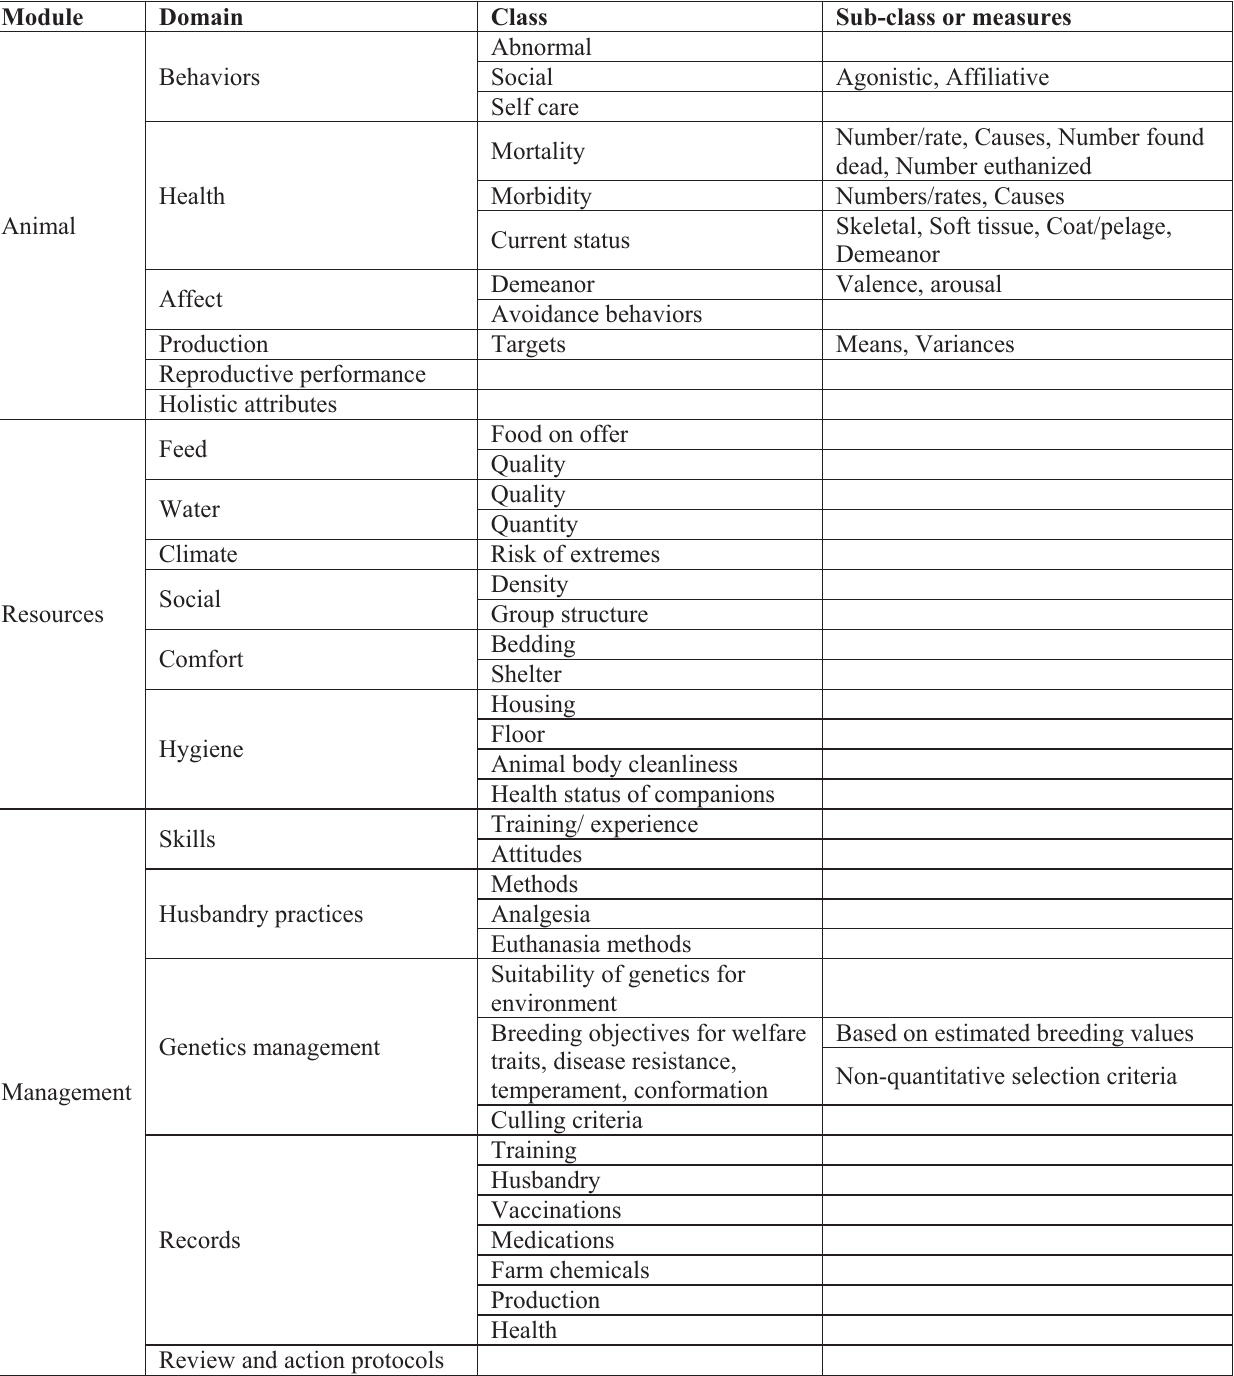
Table 1. Assessment modules and domains of the Unified Field Index (UFI) for management of on-farm welfare performance with examples of classes and sub-classes within each domain. Classes and sub-classes need to be tailored to each particular species and production